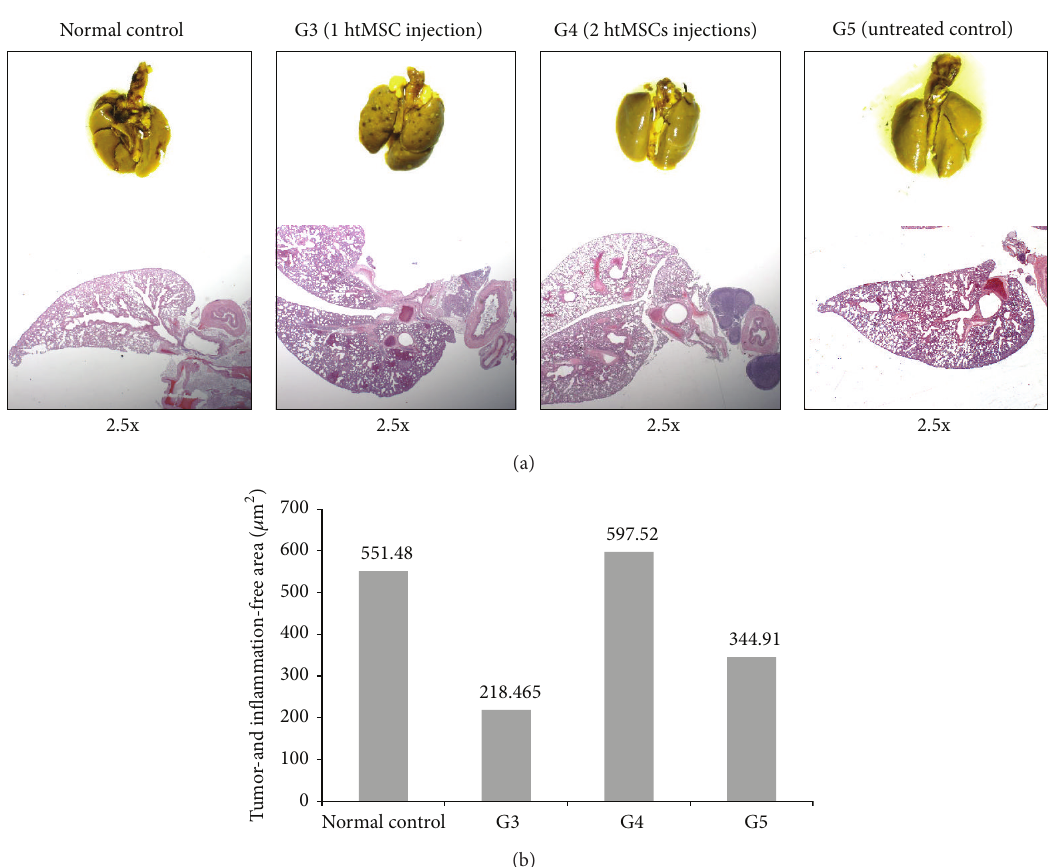
Figure 4: Inoculation of htMSCs in tumor-bearing mice. (a) Images show G3, G4, and G5 lungs (macroscopically and microscopically), in comparison with normal control (normal mice lung) 20 days after tumor cell inoculation. One representative animal of each group is shown. (b) Pulmonary tissue-free measurements, showing that lungs were preserved in G4 group (2 htMSCs injections), similar to normal controls, represented as tumor- and inflammation-free